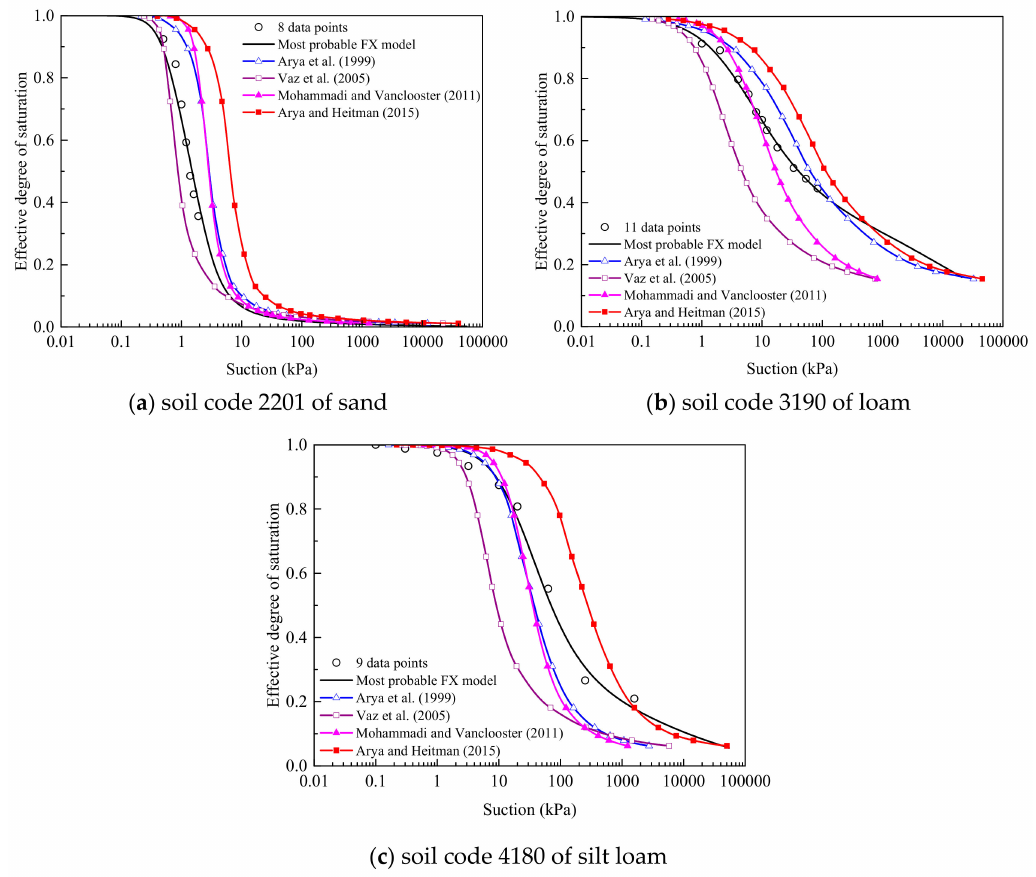
Figure 3. Comparison of di ff erent indirect methods for predicting